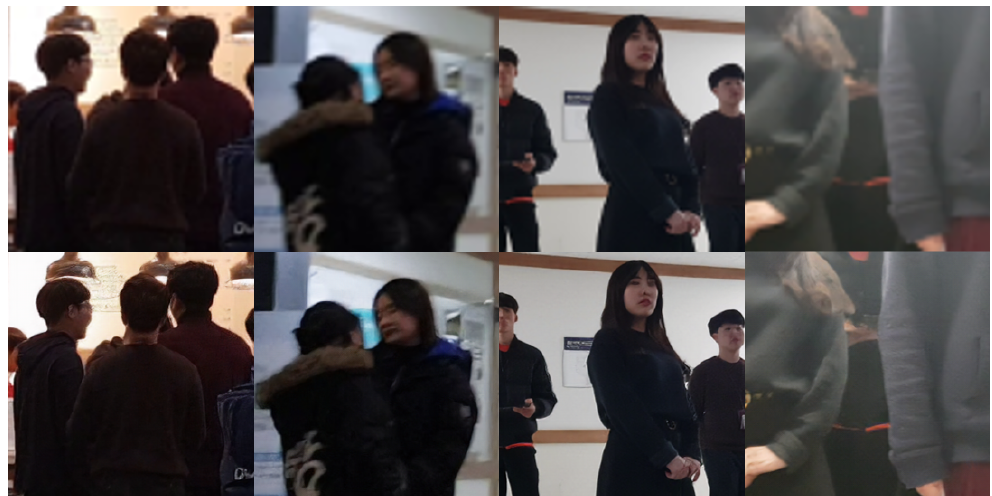
Figure 6. The examples of the image restoration. The upper and lower parts represent the raw input images and the inferred images, respectively.